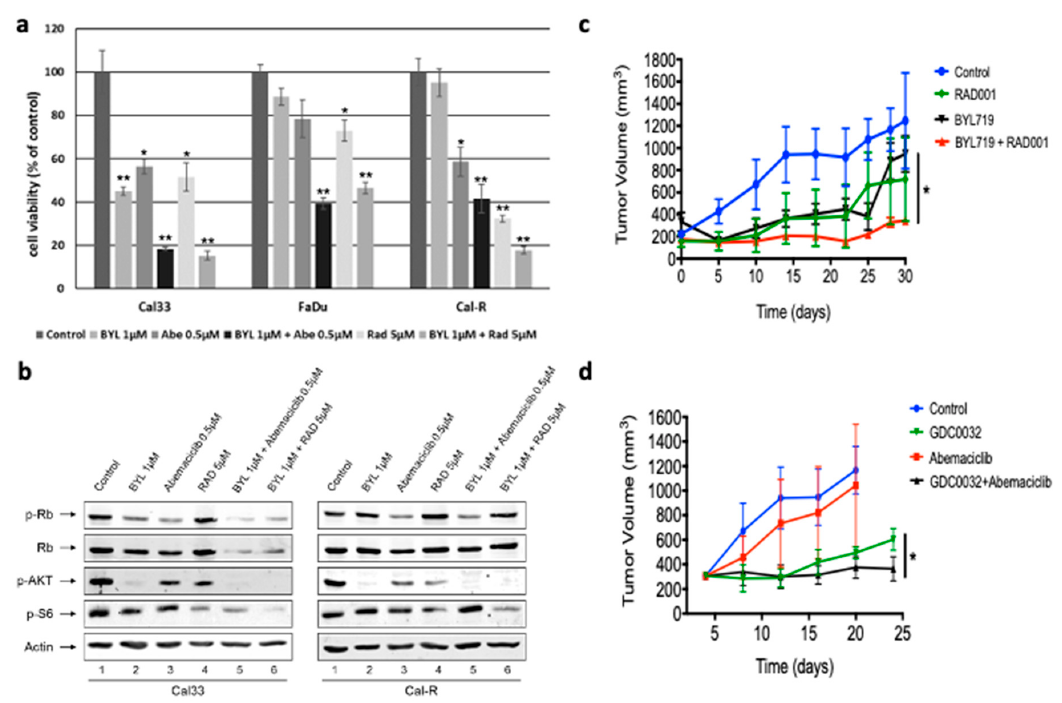
Figure 3. Overcoming resistance to PI3Ki by blocking mammalian target of rapamycin complex 1 (mTORC1) or cyclin D1 kinase (CDK) 4/6. ( a ) Cell viability curves of Cal33, FaDu, and Cal33-R cell lines, treated with either BYL719, abemaciclib, or RAD001 monotherapy or combination. ( b ) Signaling pathway protein expression in Cal33 and Cal33-R cell lines, treated with either BYL719, RAD001, and abemaciclib monotherapy or combination therapy. ( c ) Tumor growth curves of H22 patient-derived xenografts treated for 30 days with daily oral administration of either 50 mg/kg BYL719, 0.5 mg/kg RAD001, or a combination of both drugs ( n = 10). ( d ) Tumor growth curves of H22 patient-derived xenografts treated for 25 days with daily oral administration of either 5 mg/kg GDC0032, 50 mg/kg abemaciclib, or a combination of both drugs ( n = 10). (* p < 0.05, ** p < 0.01).